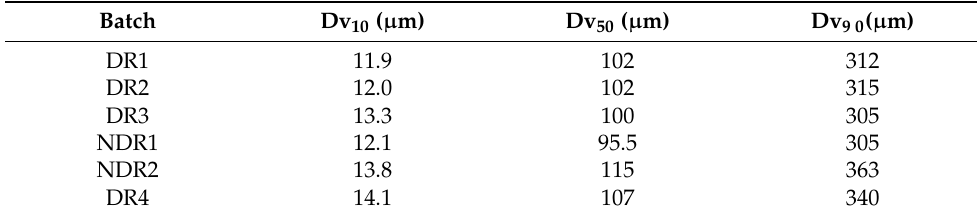
Table 7. Summary table of powders mixtures PSD